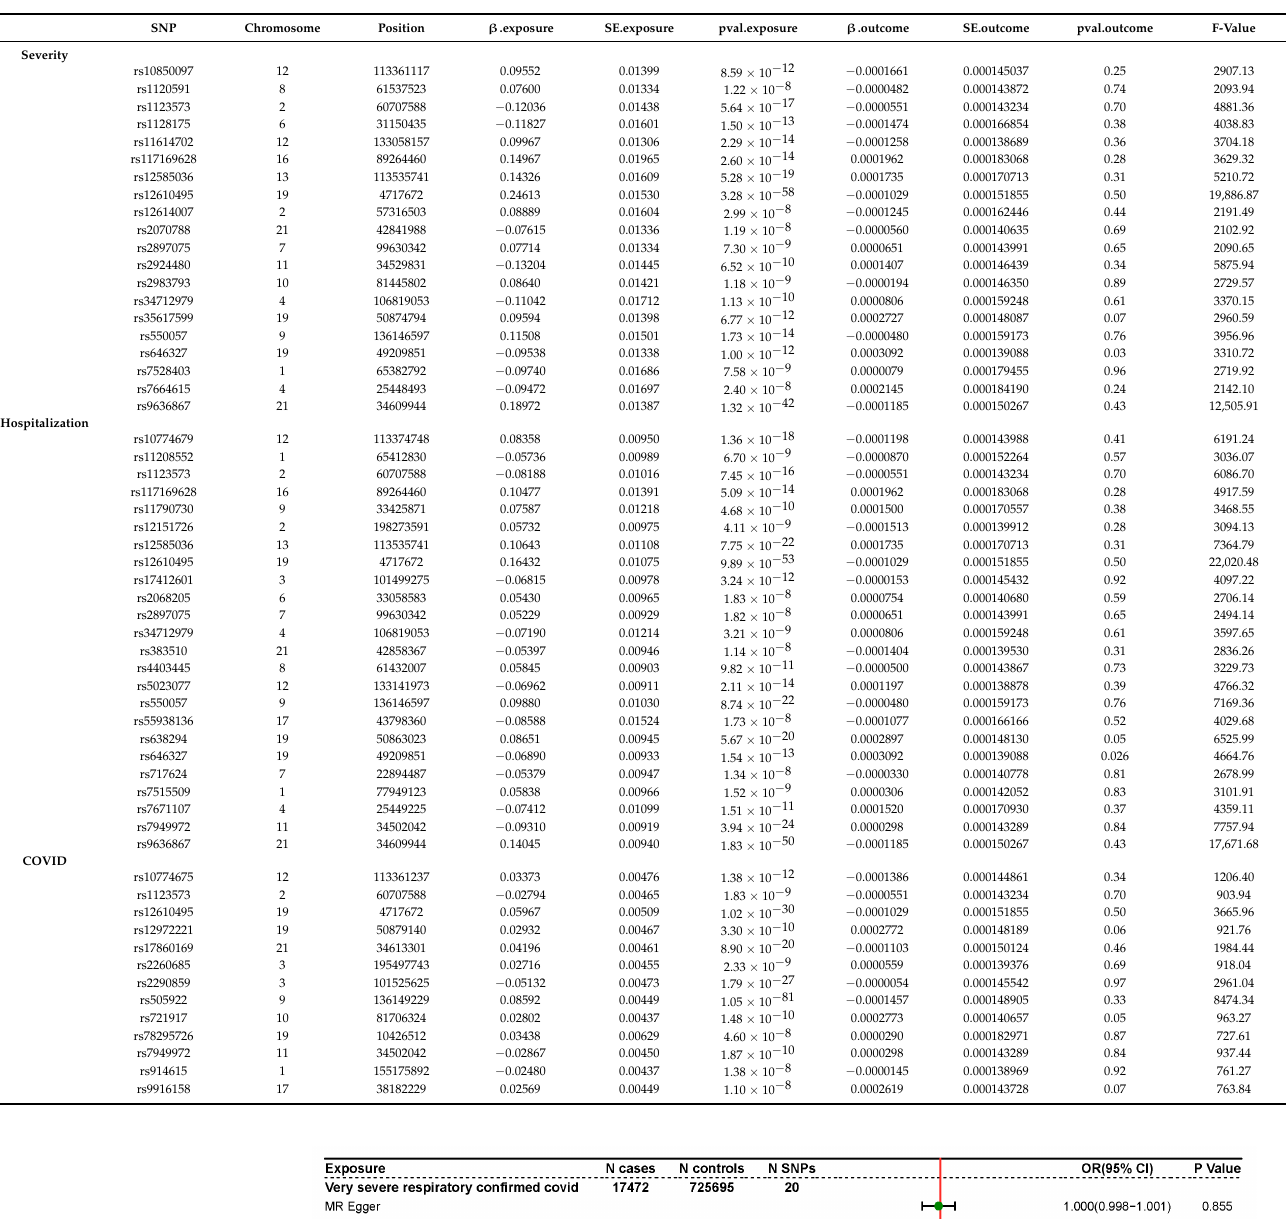
Table 1. Detail Information for SNPs.